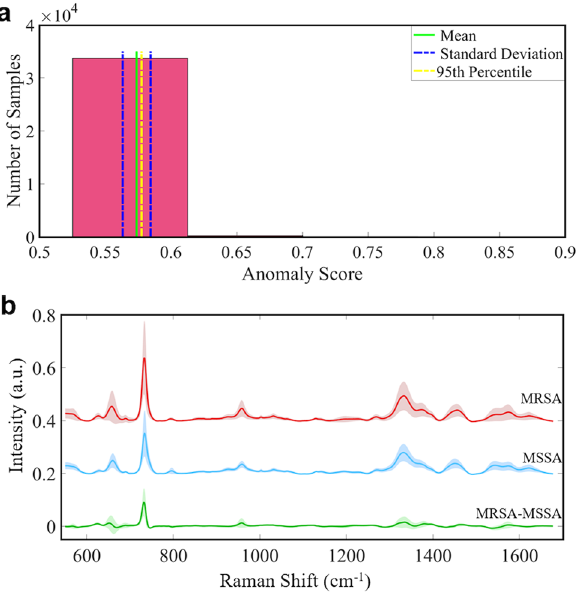
Figure 3. ( a ) Histogram plot of the anomaly score values obtained by the isolation forest algorithm. ( b ) Normalized average SERS spectra ± standard deviation of MRSA, MSSA and the difference of